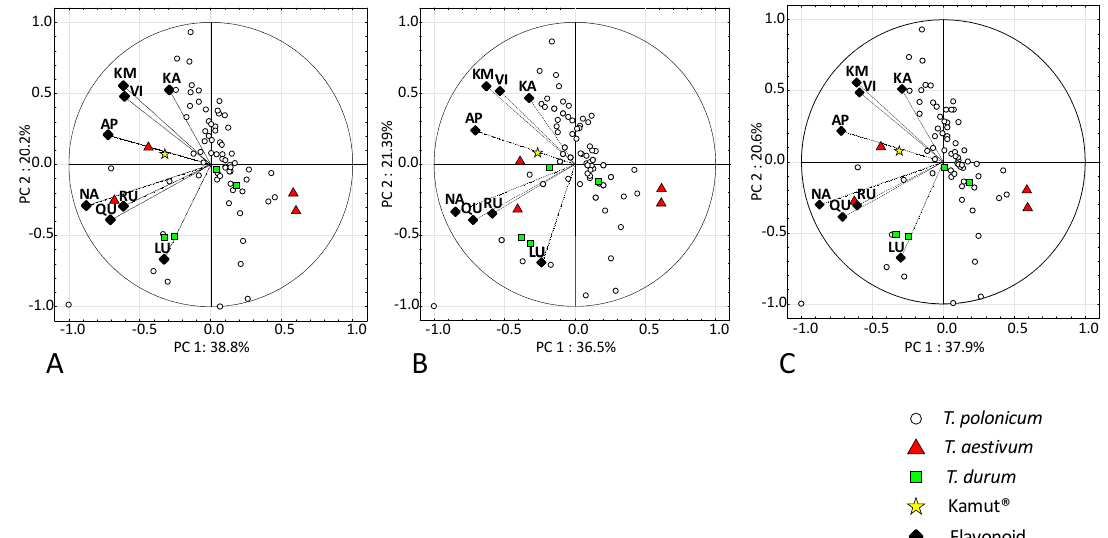
Table 4. Concentrations of the analyzed flavonoids (mg kg − 1 ) in the flour, bran, and grain of